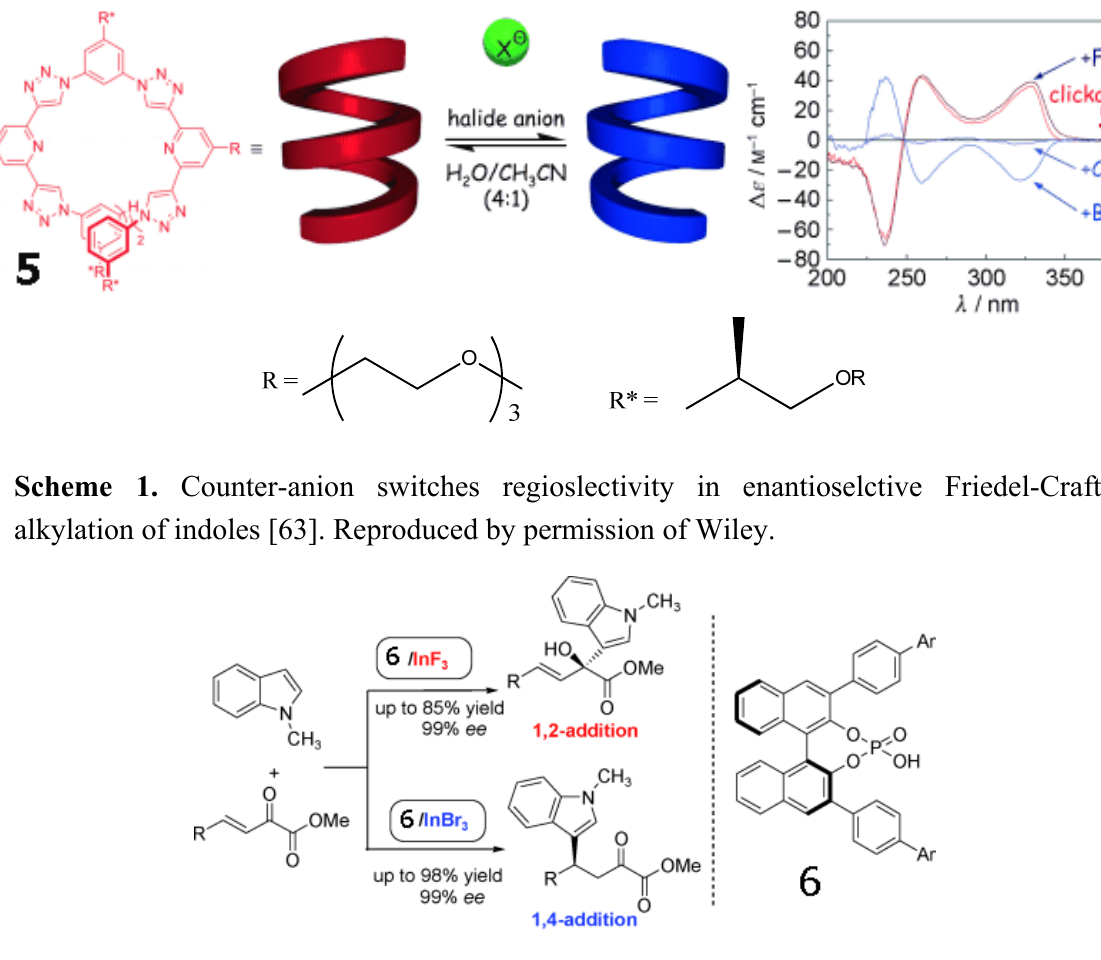
Figure 11. Optical response of clickamer 5 (8 × 10 − 6 M, 75 vol% water in acetonitrile, 25 °C) to various halide ions: KF, KCl, and KBr (all at neutral pH) as well as HCl [62]. Reproduced by permission of